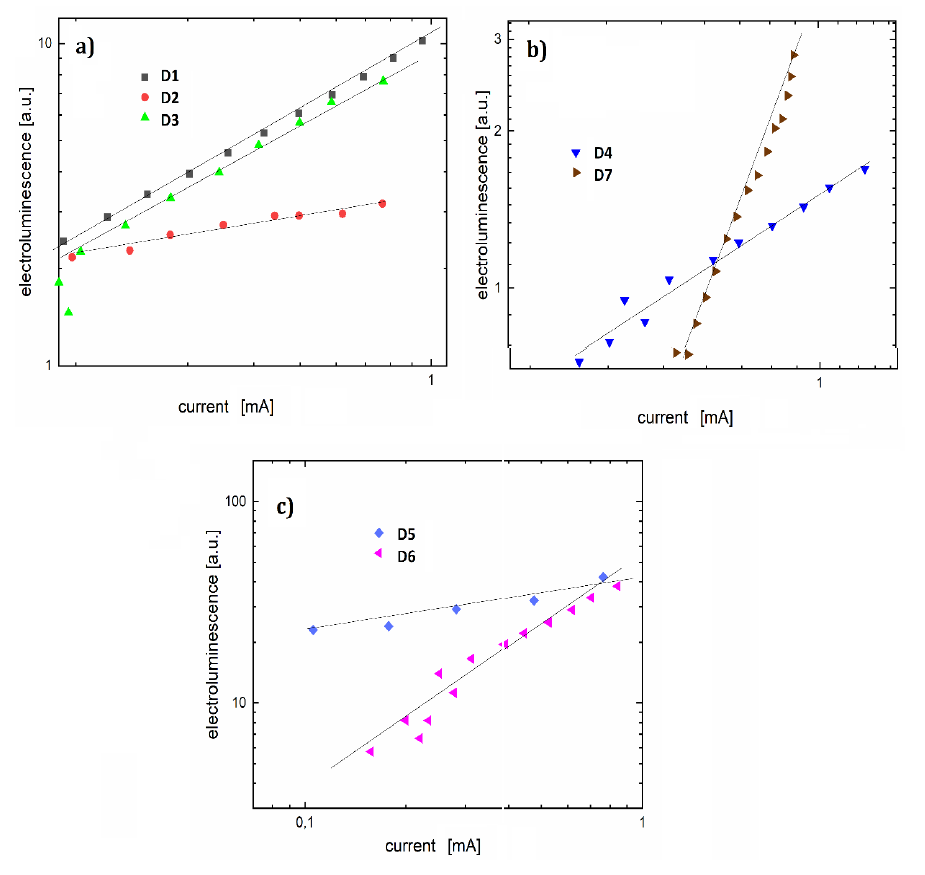
Figure 10. Log-log electroluminescence-current characteristics for organic light-emitting diodes (OLEDs) ( a ) D1, D2 and D3, ( b ) D4 and D7, ( c ) D5 and D6.